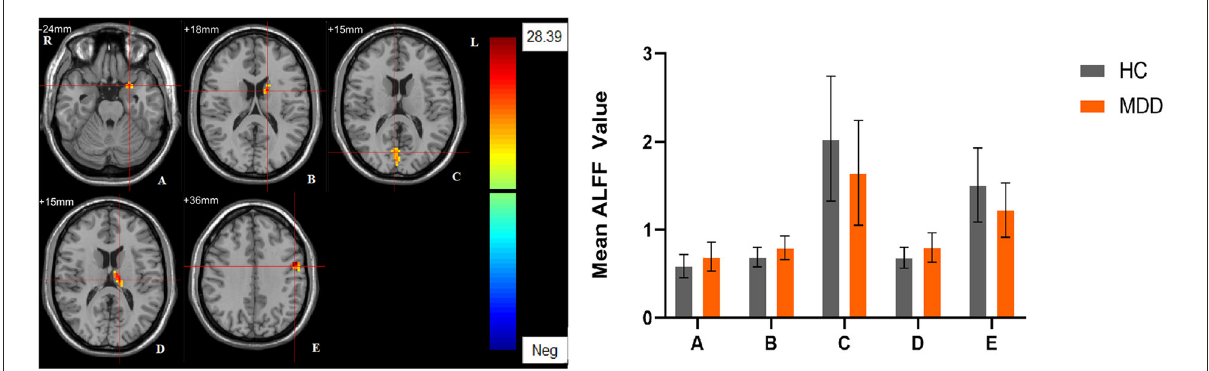
FIGURE1 The main effect of diagnostic group. Regions with a main effect of the diagnostic group included (A) The left Olfactory and the left orbital inferior frontal gyrus; (B) The left caudate; (C) The bilateral calcarine; (D) The left thalamus; (E) The left precentral gyrus and the left postcentral gyrus (cluster-level threshold of p < 0.05 after GRF correction). The color bar represents the range of F values. R = right, L = left. The graph shows the ALFF values (mean ± standard deviation) extracted from regions with a main effect of diagnostic group. The Y-axis represents ALFF values. The X-axis represents regions with a main effect of the diagnostic group.